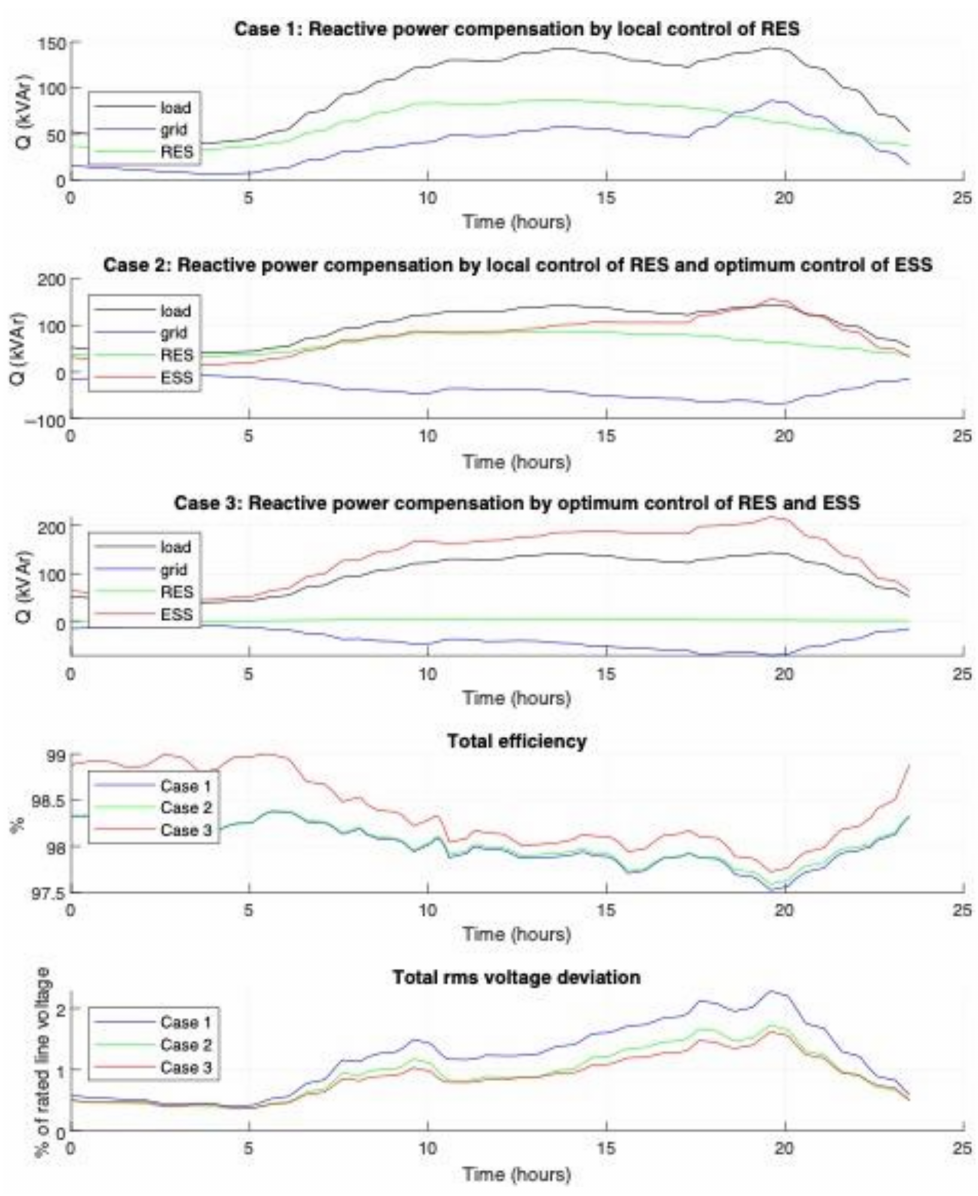
Figure 6. Results obtained considering different reactive power control